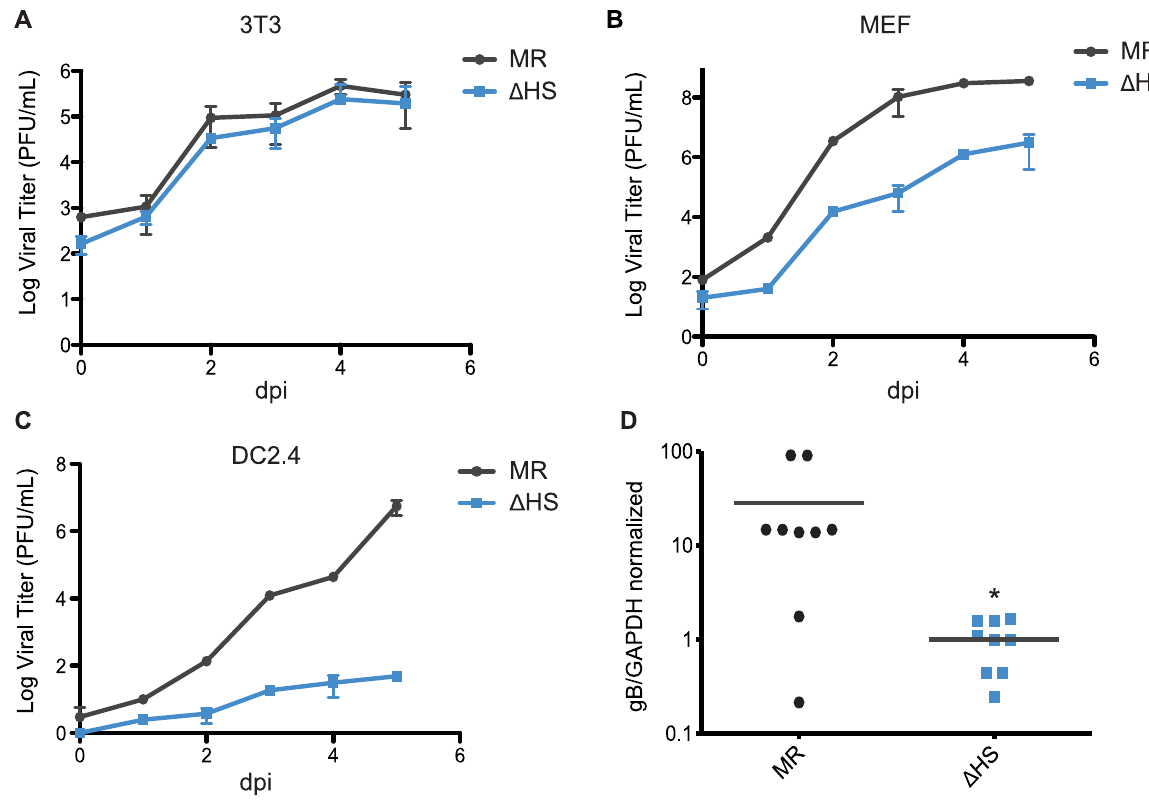
Figure 6. muSOX-induced mRNA degradation is important for viral amplification in a cell type specific manner in vitro and in vivo. (A–C) Multi-step growth curves were done in (A) NIH 3T3 cells, (B) murine embryonic fibroblasts, or (C) DC2.4 cells. Cells were infected at an MOI of 0.05 with MR or D HS MHV68, cells and supernatant collected at the indicated times post infection, and the titer was determined by plaque assay. At least three independent experiments were performed for each cell type. (D) C57BL/6 mice were infected by the intraperitoneal route with 1 6 10 3 pfu of MR or D HS MHV68. At 10 dpi spleens were harvested, homogenized, DNA extracted, and qPCR used to quantify viral particles. Each dot represents the relative value from a single spleen, and the bar indicates the mean value for each virus. * Indicates p-value ,